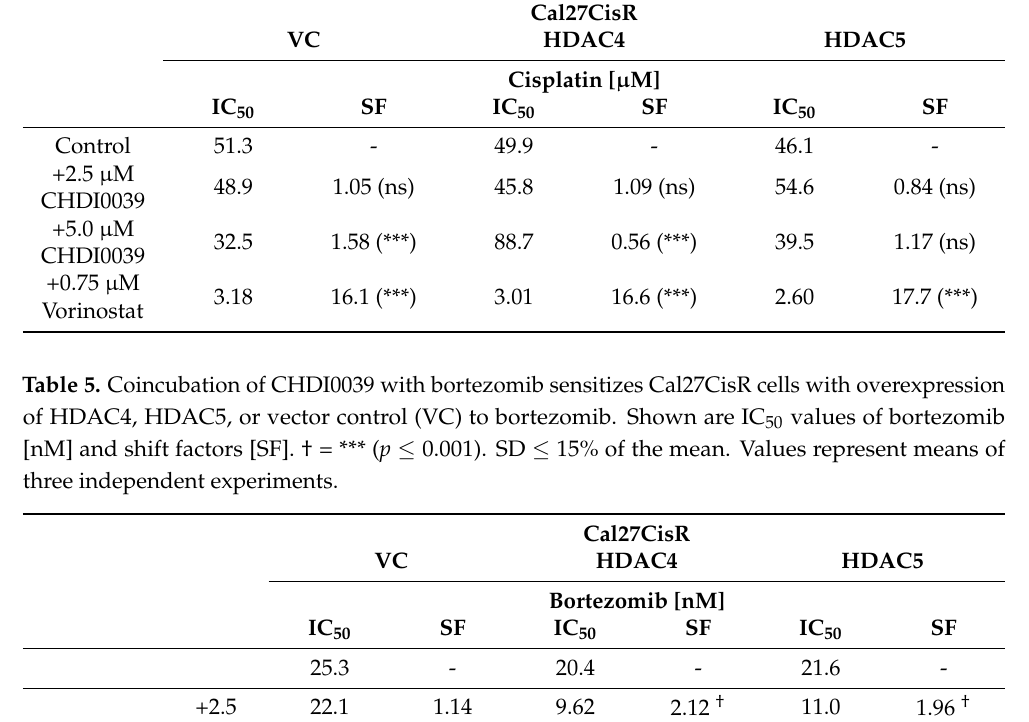
Table 4. IC 50 values of cisplatin [ µ M] in the absence and presence of 2.5 µ M/5 µ M CHDI0039 or